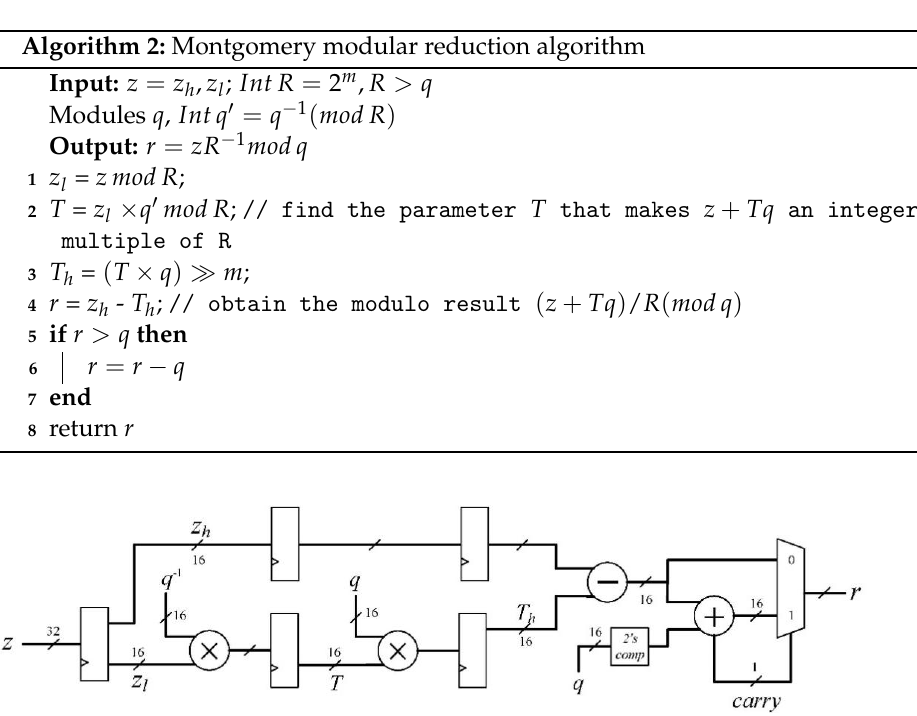
Figure 5. Montgomery modular multiplication hardware